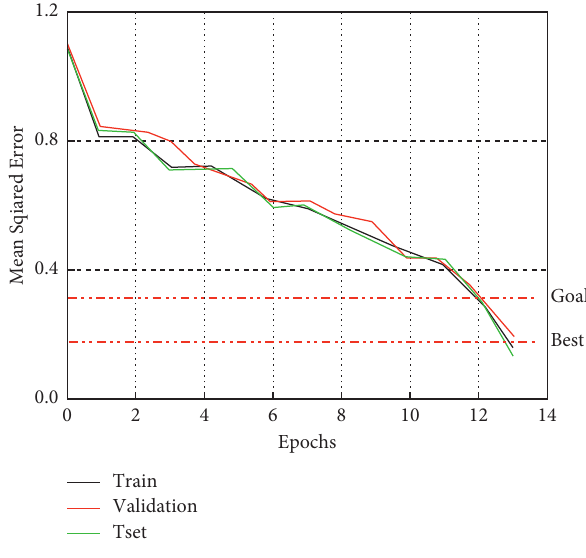
Figure 4: Training process